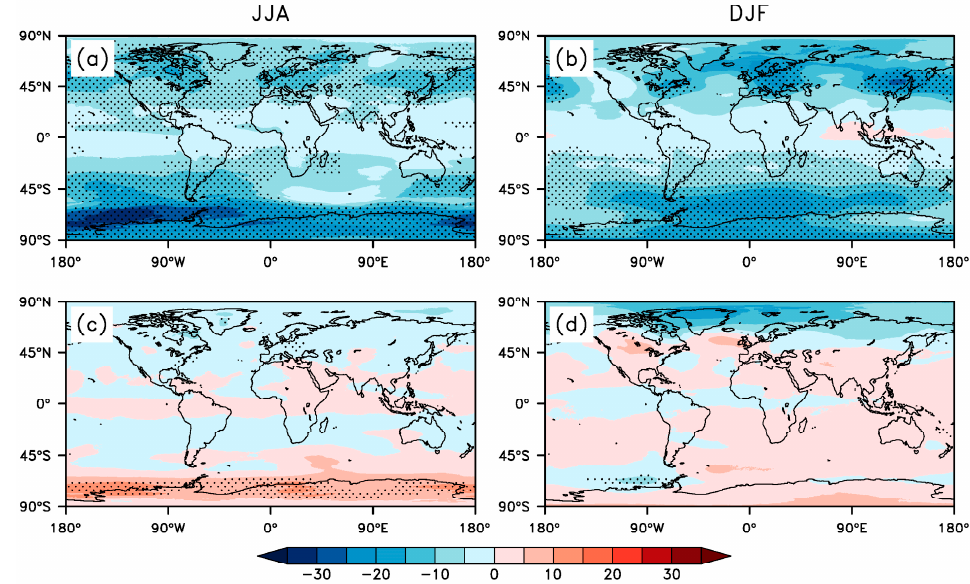
Figure 2. Geographic distributions of linear trends of total column ozone over ( a , b ) 1979–1997 and ( c , d ) 1998–2020 in ( a , c ) JJA and ( b , d ) DJF. Regions with dots are the places where trends have statistical significance levels higher than the 95% confidence level.